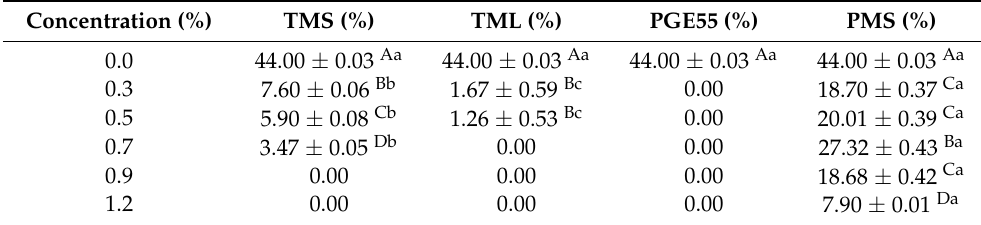
Table 1. The effect of the concentration of PGEs on serum loss.